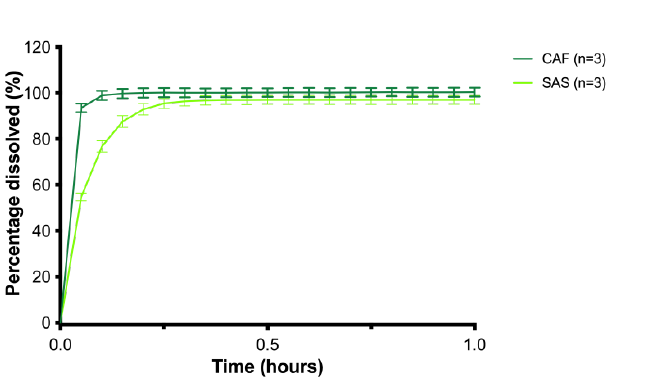
Figure A2. Reproducibility of SAS and CAF release in 1000 mL GISS phase III from three different Table A1. Characteristics of different batches of the MCC_CCS4_EtOH pellet formulation.